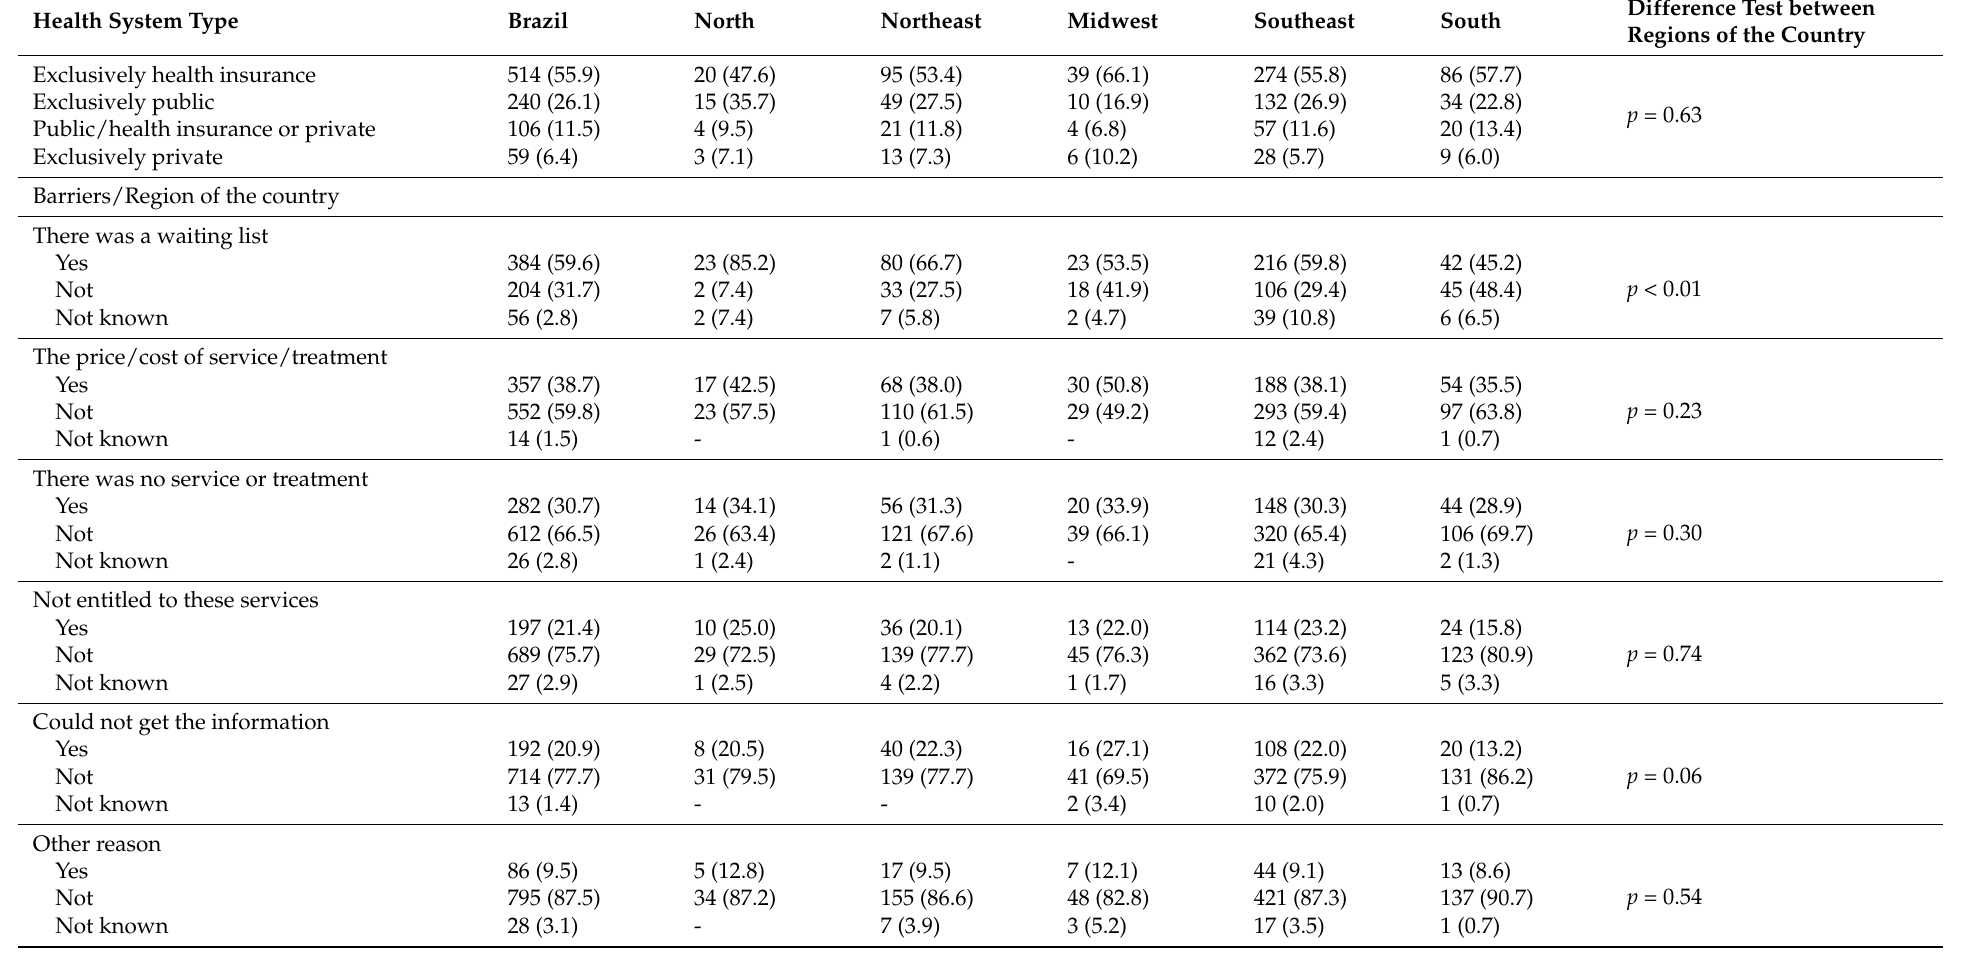
Table 3. Health System, barriers to access to treatment and financial impact of ASD (N =